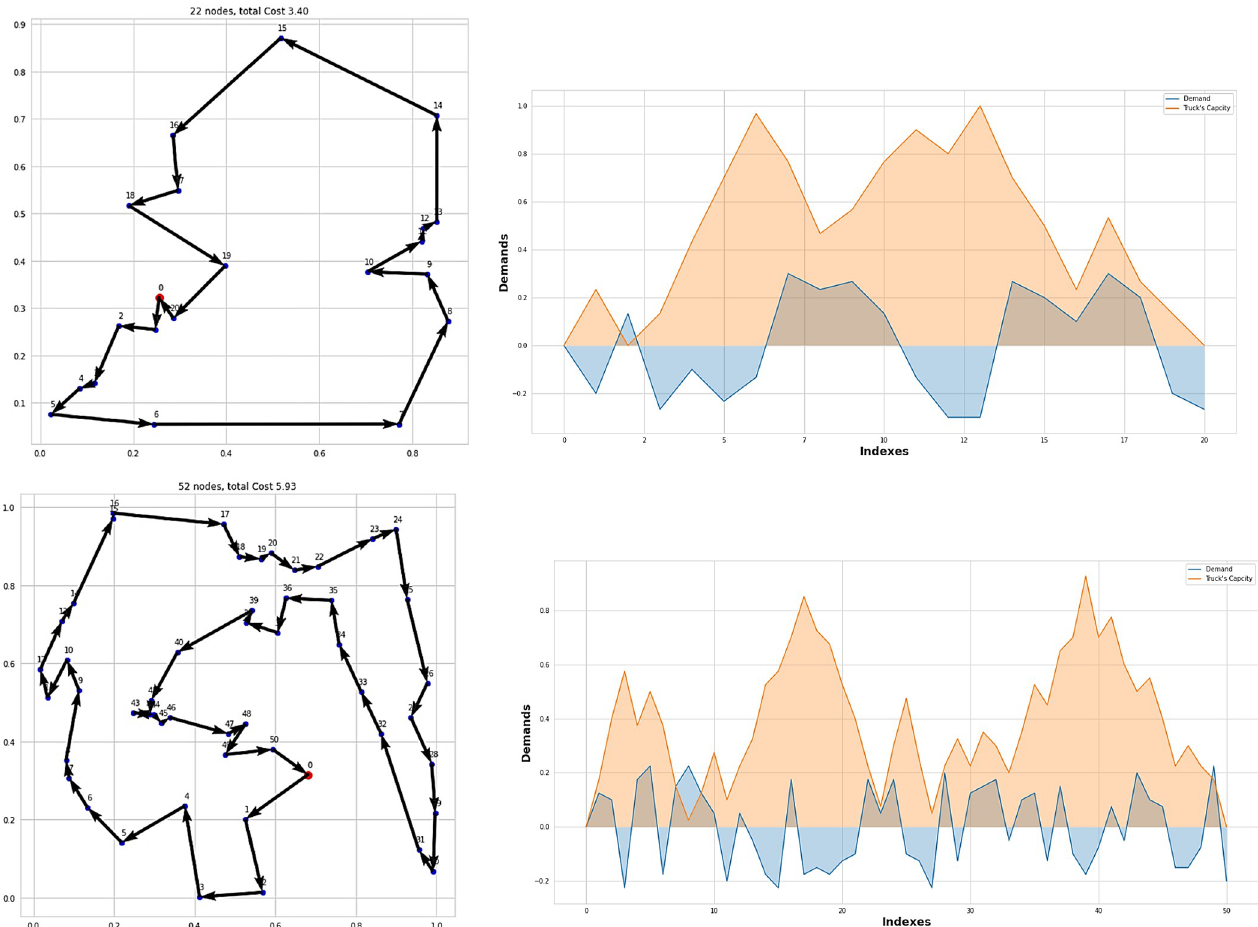
Fig 4. Sample instances for BBS21 and BBS51, with each point labeled with its demand and the vehicle remining capacity once the vehicle served this point.